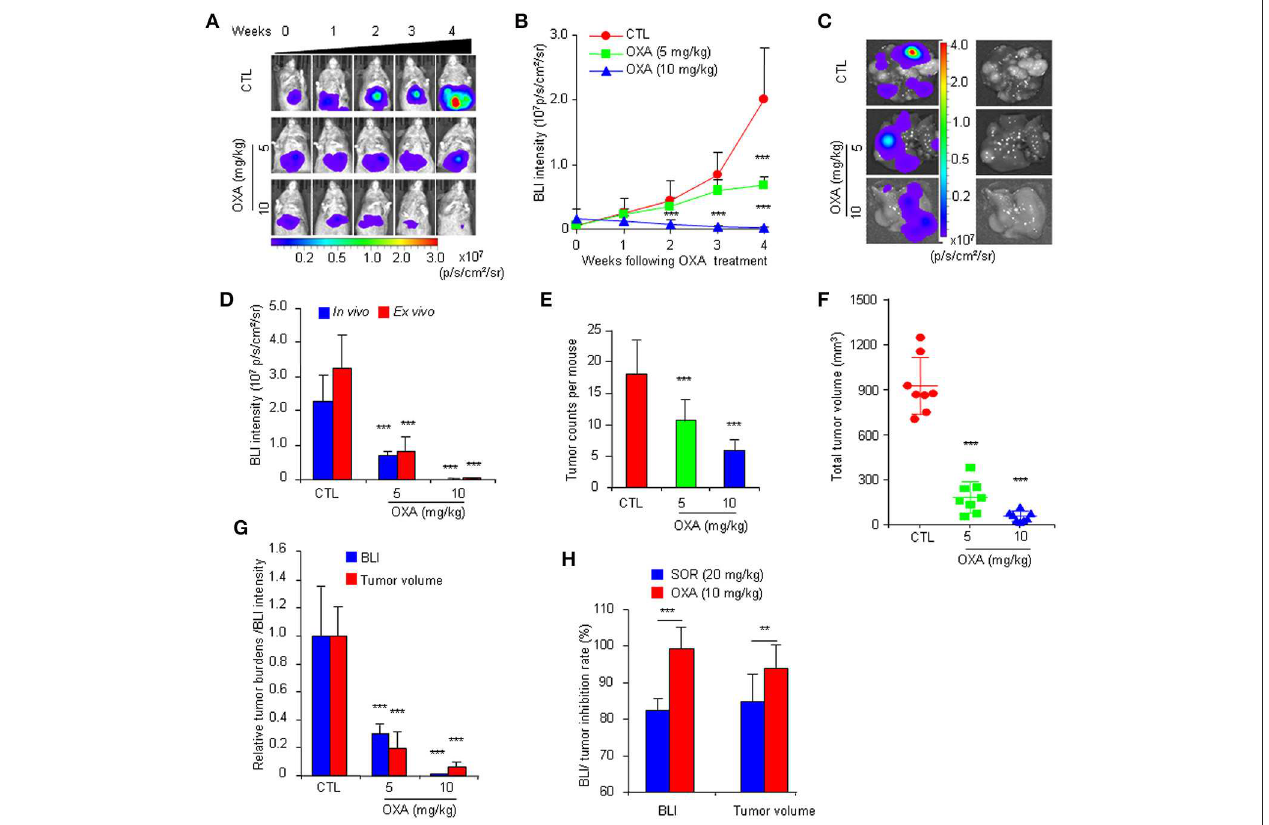
FIGURE 4 | Non-invasive BLI monitoring of the tumor inhibitory effects of oxaliplatin in HCR mice. (A) Serial bioluminescence imaging of representative mice treated with 5 or 10 mg/kg oxaliplatin (OXA) or vehicle solution (CTL). (B) in vivo quantified bioluminescence intensity in mice that underwent vehicle or oxaliplatin treatment ( n = 8). (C) Photograph showing the final ex vivo BLI intensity and liver tumors upon autopsy. (D) In vivo and ex vivo BLI intensity in mice after oxaliplatin treatment ( n = 8). (E) Group tumor burdens are presented based on the tumor count in each mouse ( n = 8). (F) Group tumor burdens are presented based on the total tumor volume in individual mice ( n = 8). (G) Relative tumor burden/BLI intensity in mice that underwent vehicle or oxaliplatin treatment ( n = 8). (H) BLI intensity/tumor inhibition rate of sorafenib and oxaliplatin ( n = 8). ** P < 0.01 vs. CTL, *** P < 0.001 vs. CTL.